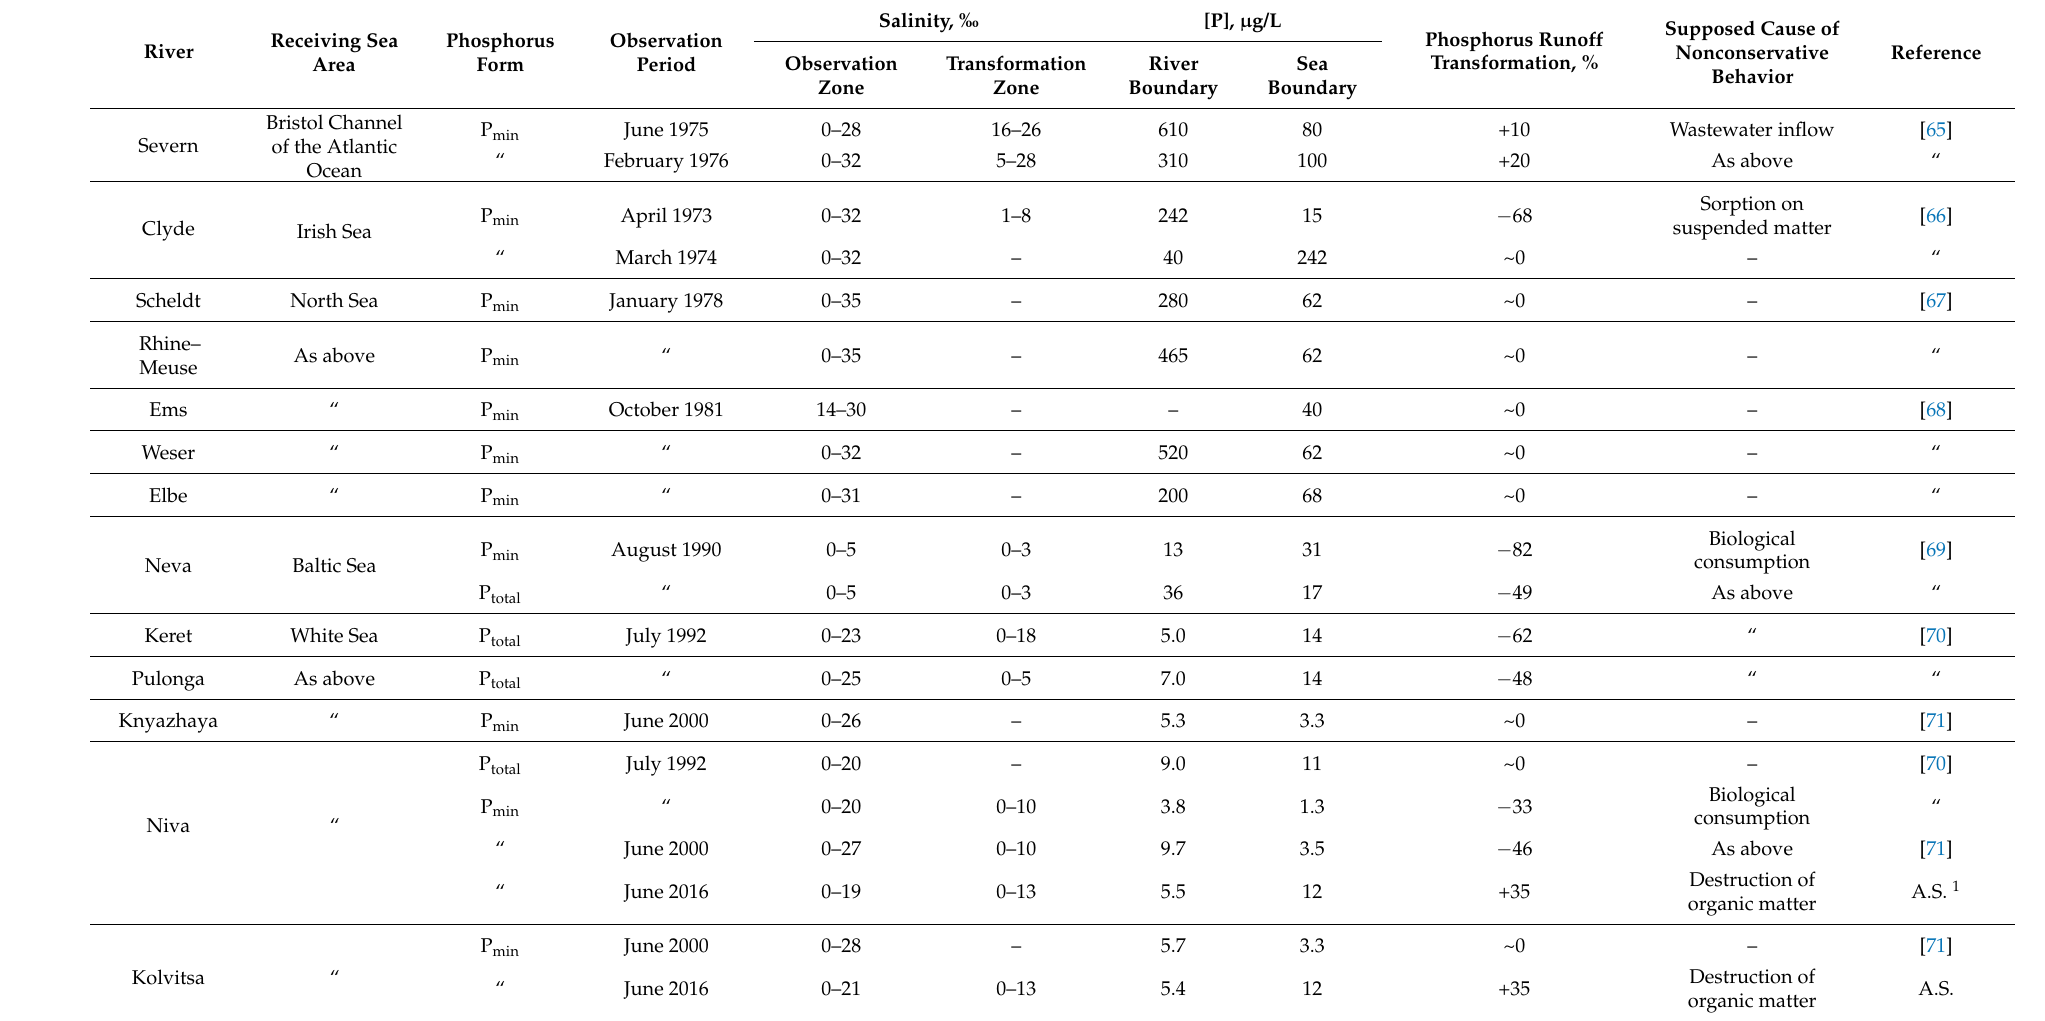
Table 16. The behavior of dissolved phosphorus in the mouth areas of world